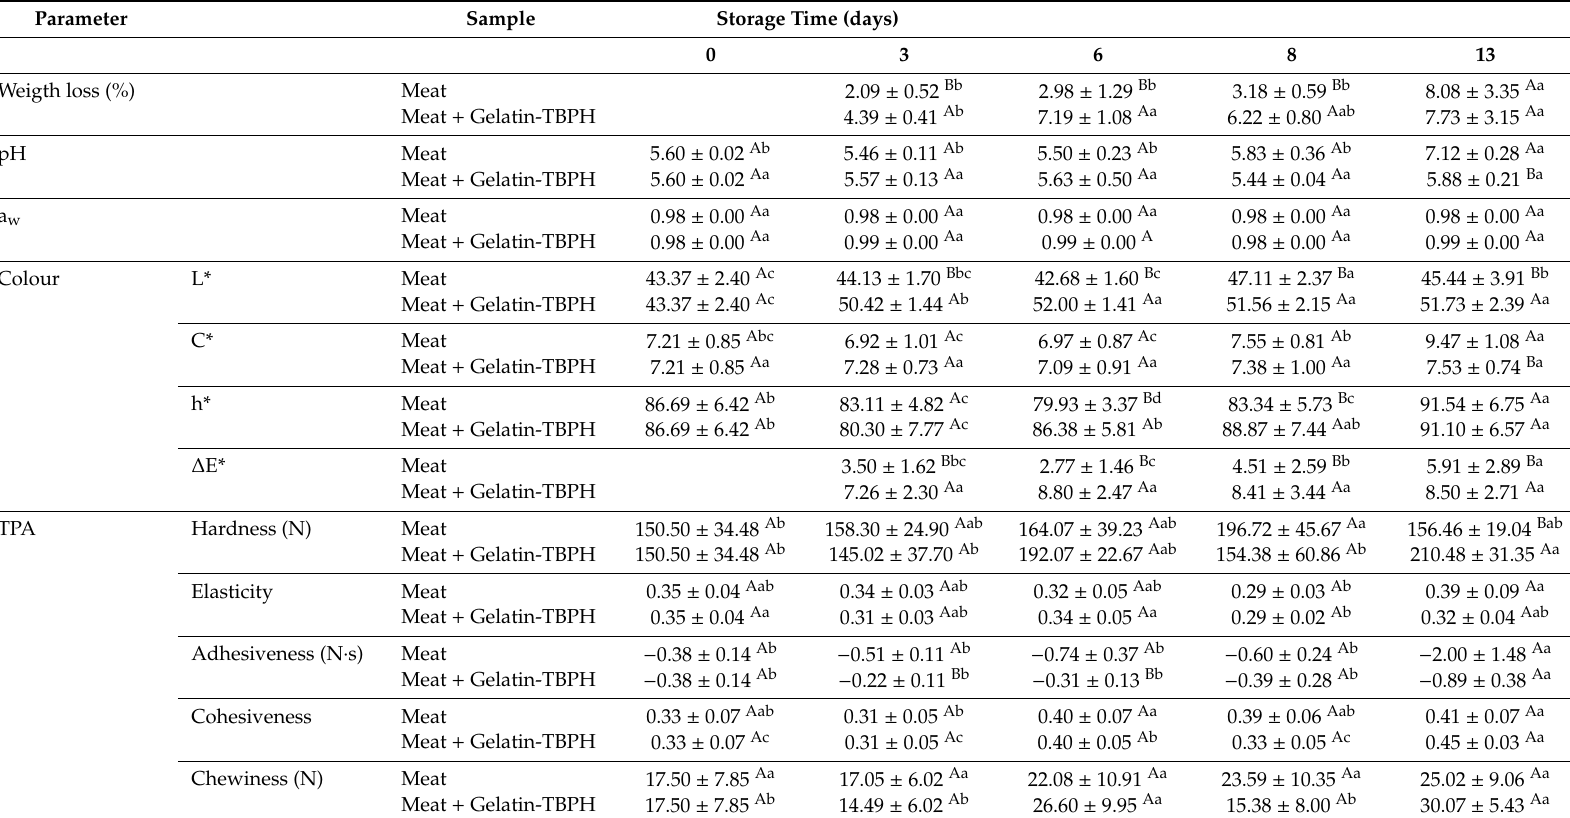
Table 2. Changes in physicochemical parameters of uncoated meat and meat coated with gelatin enriched with tomato by-products hydrolysate (TBPH) during cold